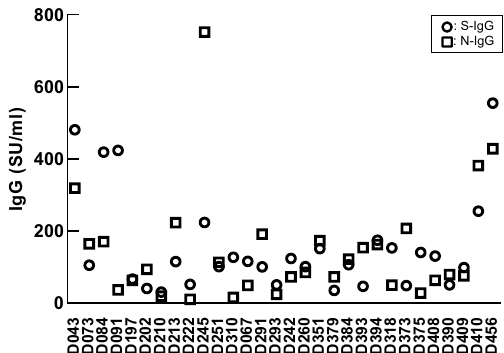
Figure 2. Anti-SARS-CoV-2 antibody titers in individual